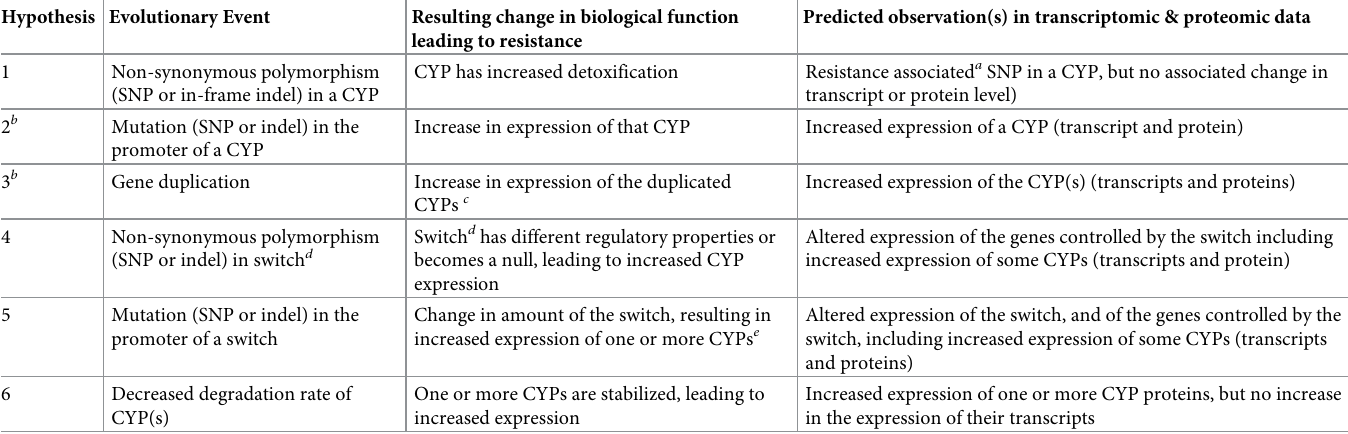
Table 1. Six hypotheses to explain increased CYP-mediated resistance that are testable with RNA-seq and/or proteomic data. Hypothesis Evolutionary